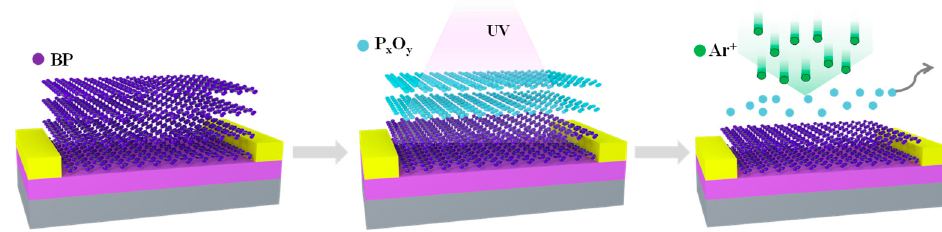
Figure 1. Schematic diagram of thinning process of the BP flakes. Slight UVO radiation was intro- duced to oxidize the BP flakes, and Ar plasma was used to remove the